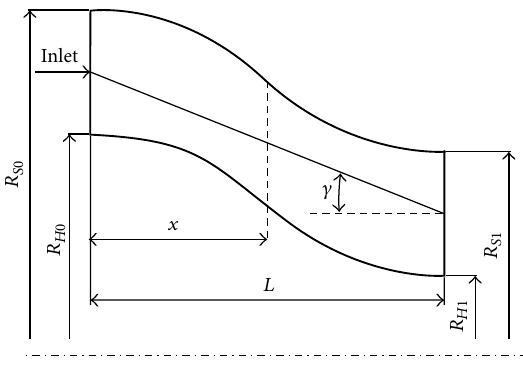
Figure 3: Parametric s-shaped annular flow duct geometry.